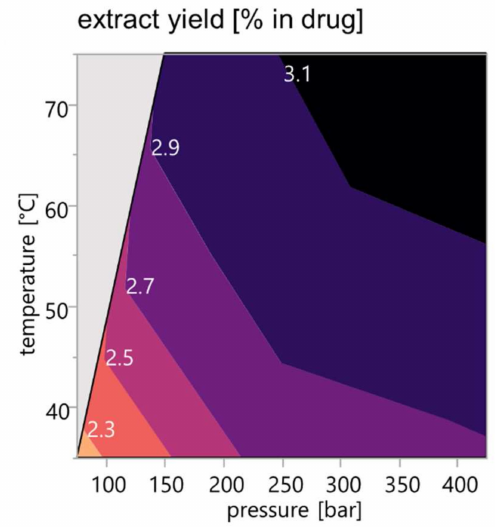
Figure 3. Response contour plot illustrating the extract yields depending on pressure and temperature; the area marked in grey represents combinations of pressure and temperature settings, which were not investigated; recovery rate related to the drug material in % ( m / m